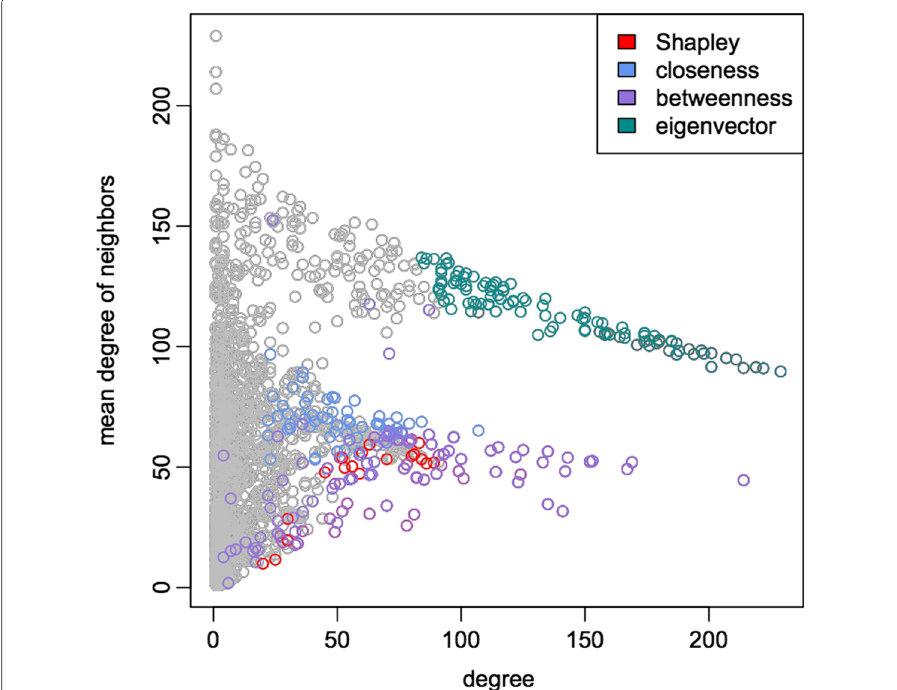
Fig. 9 Comparison of the relation among the degree of a node and the degree of its neighbours. The points represent genes and their coordinates are given, respectively, by the degree of a gene (on the x -axis) and the mean degree of its neighbours (on the y -axis). The coloured points represent the genes selected by the different centrality